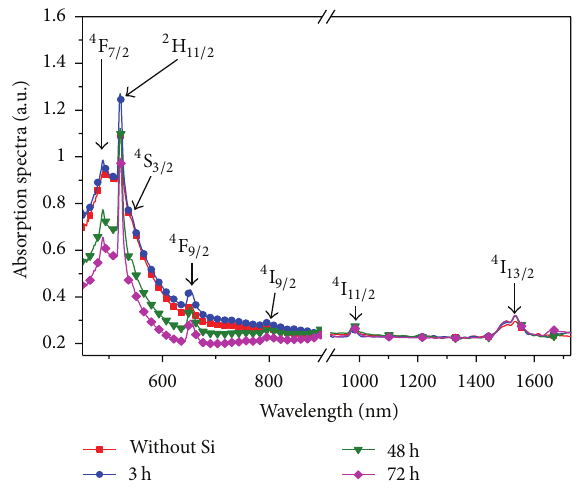
Figure 19: Absorption spectra of Er 3+ doped GeO 2 -Bi 2 O 3 glass heat-treated during different time intervals to nucleate Si-NPs. The spectrum of a sample without NPs is shown for reference